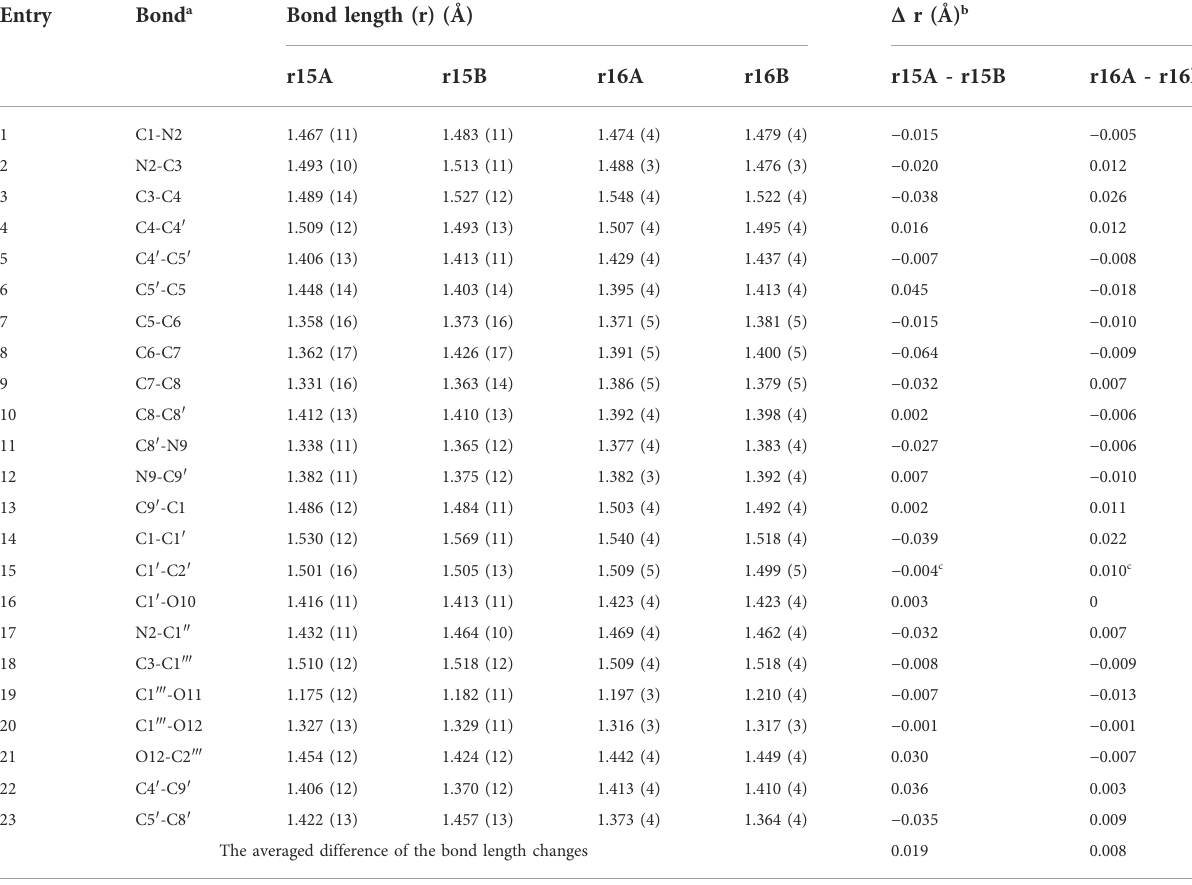
TABLE 1 The bond lengths of compounds 15 to 16 and bond length differences of the corresponding bonds in two geometries A and